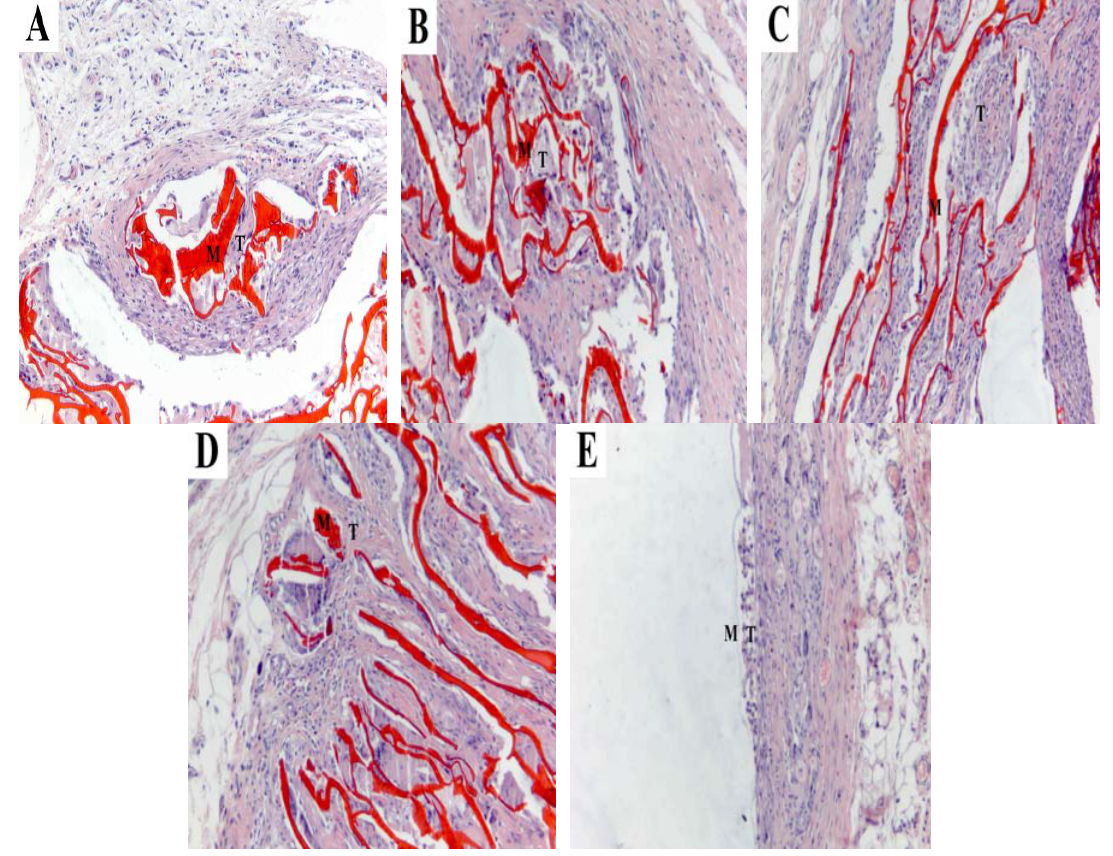
Figure 8. Histological sections of CS, PCLA and PLA scaffolds after 4 weeks of implantation ( A ) CS; ( B ) PCLA- Ι ; ( C ) PCLA- ΙΙ ; ( D ) PCLA- ΙΙΙ ; ( E ) PLA.M stand for materials and T stand for tissues (100×).